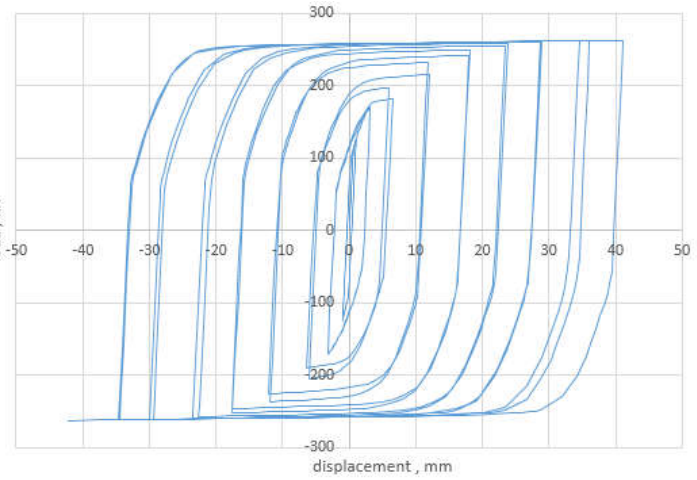
Figure 15. The hysteresis diagram resulting from the analysis of this sample in cyclic loading .